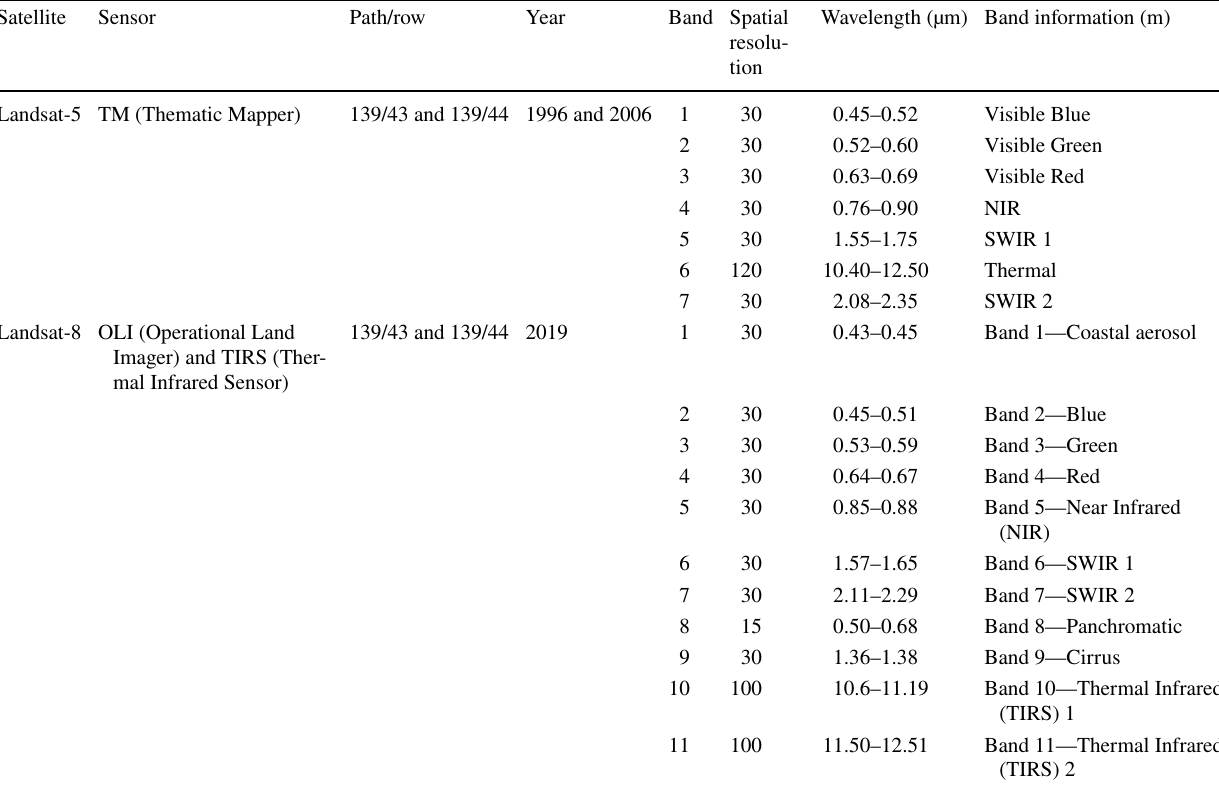
Table 1 Band information and specification of LANDSAT TM and LANDSAT OLI. Source: www. usgs. gov Satellite